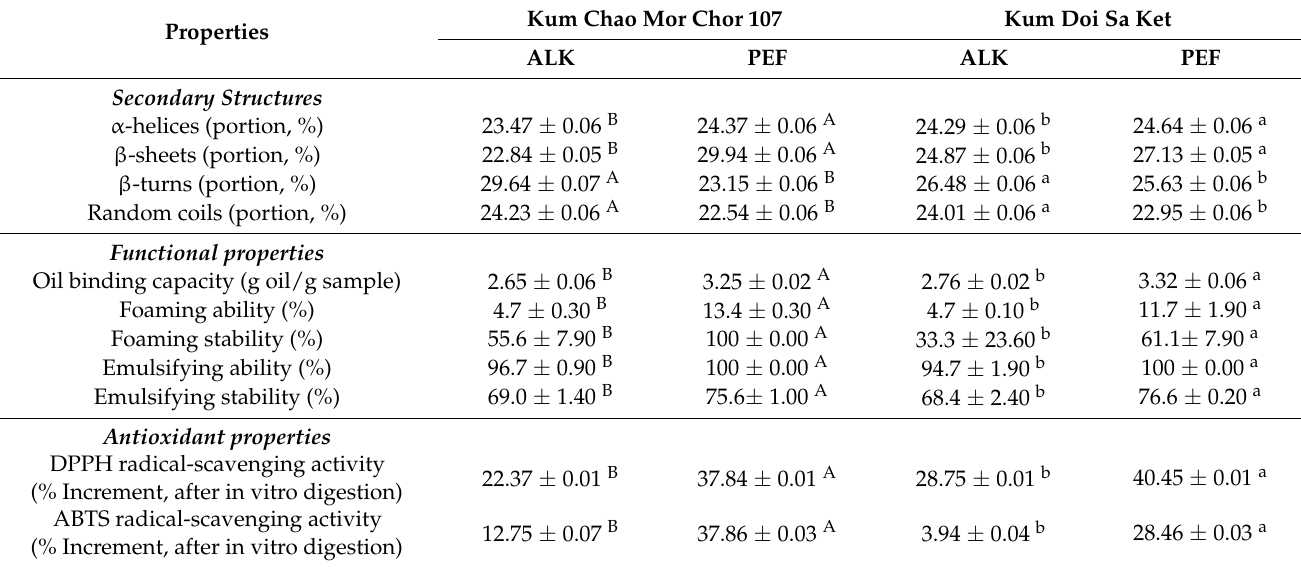
Table 3. Secondary structure changes and functional and antioxidant properties of rice bran